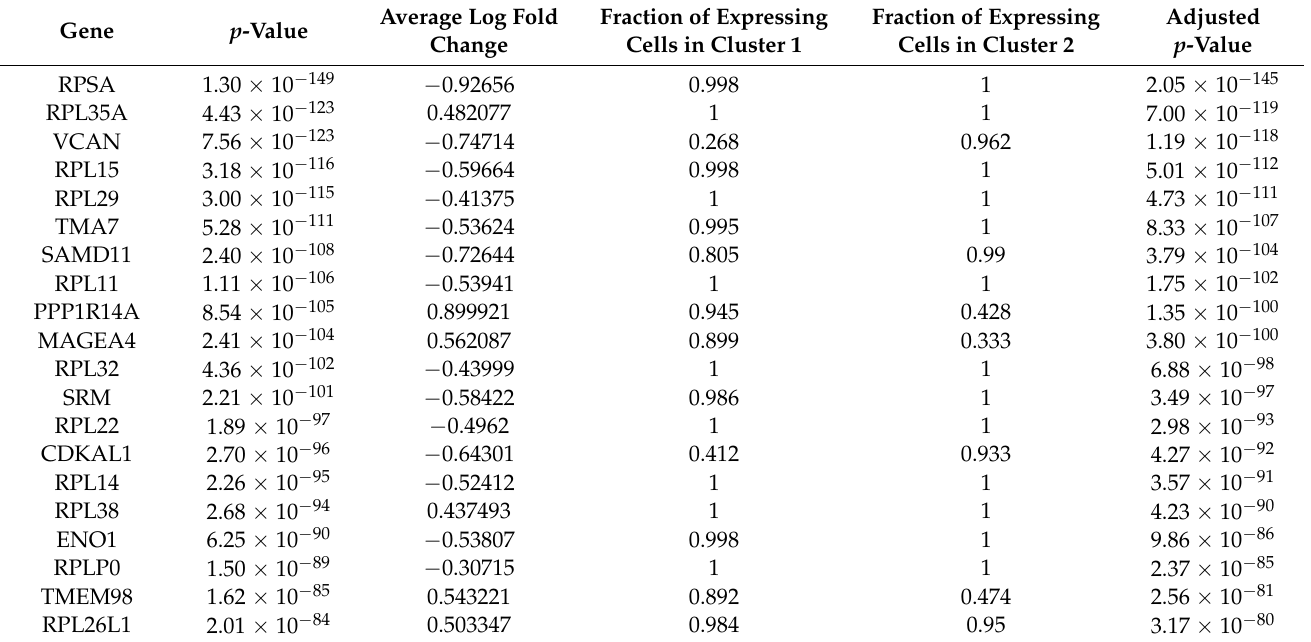
Table 1. Top 20 marker genes differentiating cluster 2 and cluster 1 of BE2C cells (see Figure 3A), according to Seurat analysis. A negative log fold change indicates lower expression in Cluster 2, and a positive log fold change a higher expression in Cluster